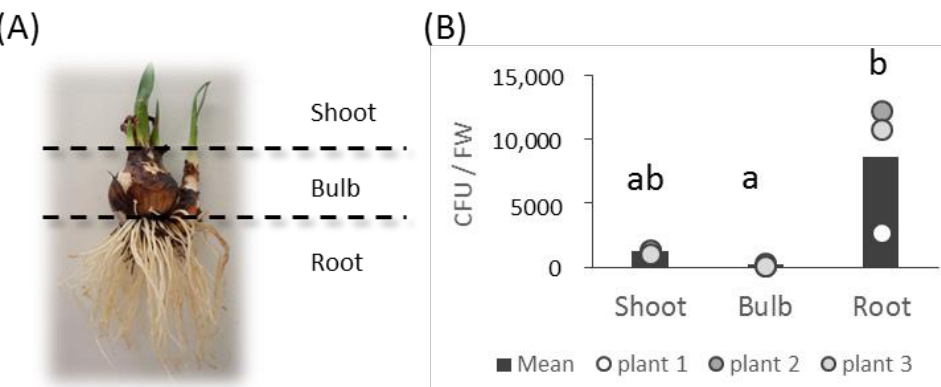
Figure 1. A used plant (plant 2) ( A ) and the number of colonies on TSA medium from 1 g of each fresh material after 20 days ( B ). CFU was tested with the Tukey – Kramer test, and the same letters (a, b) have no significant difference with p < 0.05.